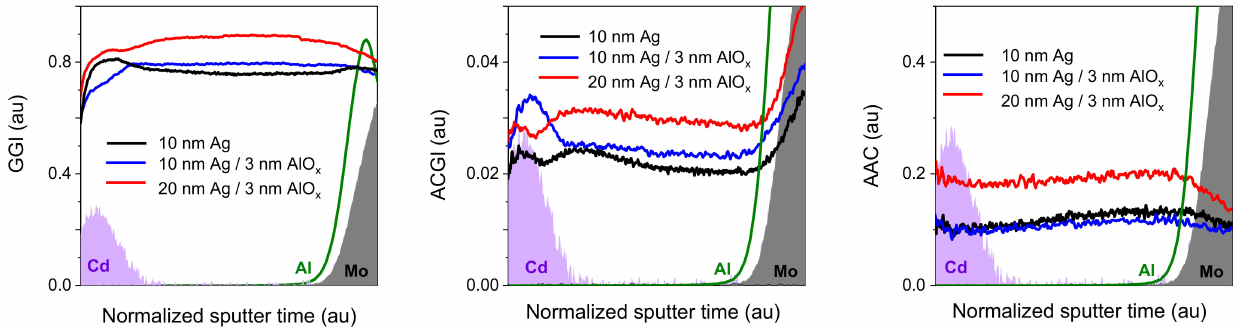
Figure 5. Non-quantified GGI, ACGI and AAC atomic ratios determined from ToF-SIMS measurements. The sputter time for each cell was adapted in such a way that the Cd and Mo signals were overlapping. Furthermore, the Al signal of the 10 nm sample is shown.